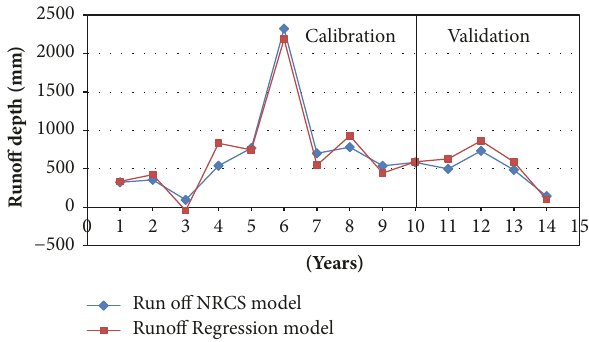
total domestic water requirement for the population of the watershed with 4.576 km 2 is estimated at 407 m 3 /day, which is 0.148 MCM per